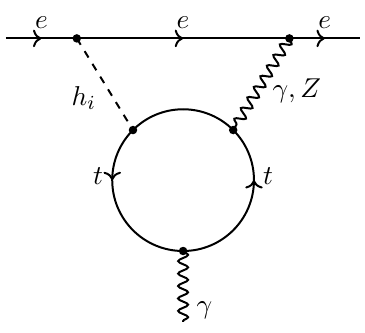
Figure 9 . The 2 -loop Bar-Zee diagram that contributes to the electron electric dipole moment [169]. Here h i denotes the mass eigenstates h and s